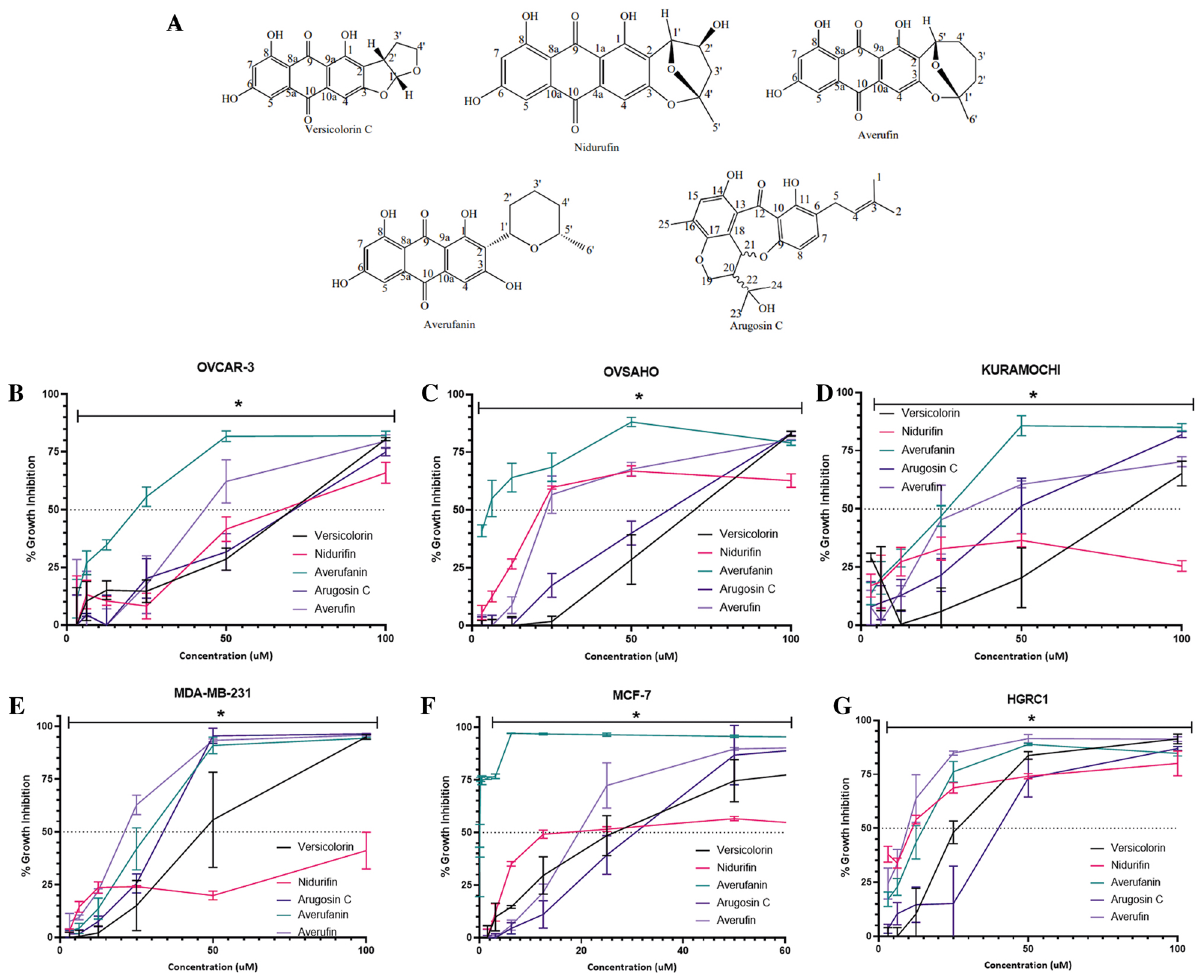
Figure 1. Bioactivities of the compounds isolated from Aspergillus Carneus. ( A ) Chemical structures of the isolated molecules drawn in ChemDraw. Percent growth inhibition curves were characterized by NCI SRB assay on ovarian (( B ) OVCAR3, ( C ) OVSAHO, ( D ) KURAMOCHI) and breast (( E ) MDA-MB-231, ( F ) MCF-7) cancer cell lines or non-tumorigenic cell line (( G ) HGRC1) treated with the compounds for 72 h in increasing concentrations (0.2–100 µM). The experiment was conducted in triplicate and absorbance values were normalized to DMSO negative controls. Significantly difference compared to DMSO treated cells (*p < 0.05).